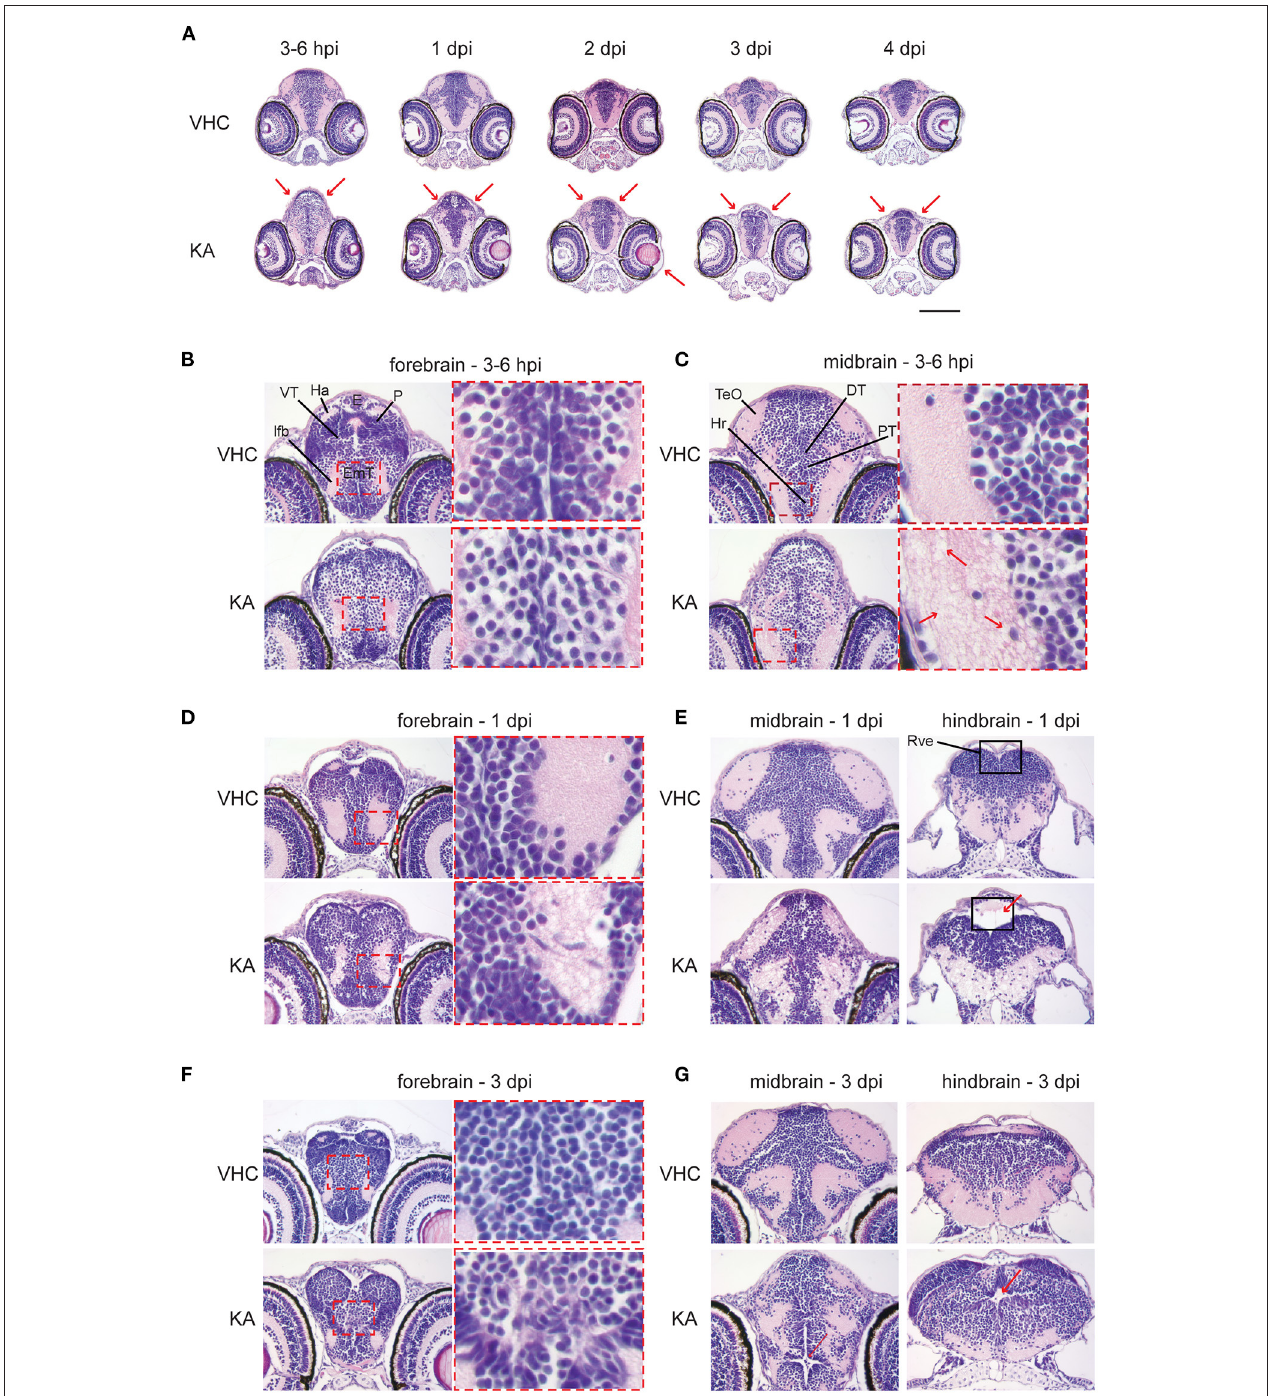
FIGURE 3 | Histopathological analysis reveals that kainic acid (KA) injection induces whole brain abnormalities. Representative images of hematoxylin and eosin (H&E) staining on paraffin cross-brain sections of KA-injected larvae in comparison to VHC-injected siblings. (A) Abnormal brain shape was observed at 2–3 hpi until 4 dpi, marked with red arrows. Scale bar 500 µ m. Selected brain abnormalities in KA-injected larvae from different parts of the brain at 3–6 hpi (B,C) , 1 dpi (D,E) and 3 dpi (F,G) . Red rectangles and arrows highlight the histopathological changes and its magnification. DT, dorsal thalamus; E, epiphysis; EmT, eminentia thalami; Ha, habenula; Hr, rostral hypothalamus; lfb, lateral forebrain bundle; P, pallium; PT, posterior tuberculum; Rve, rhombencephalic ventricle; TeO, optic tectum; VT, ventral thalamus.